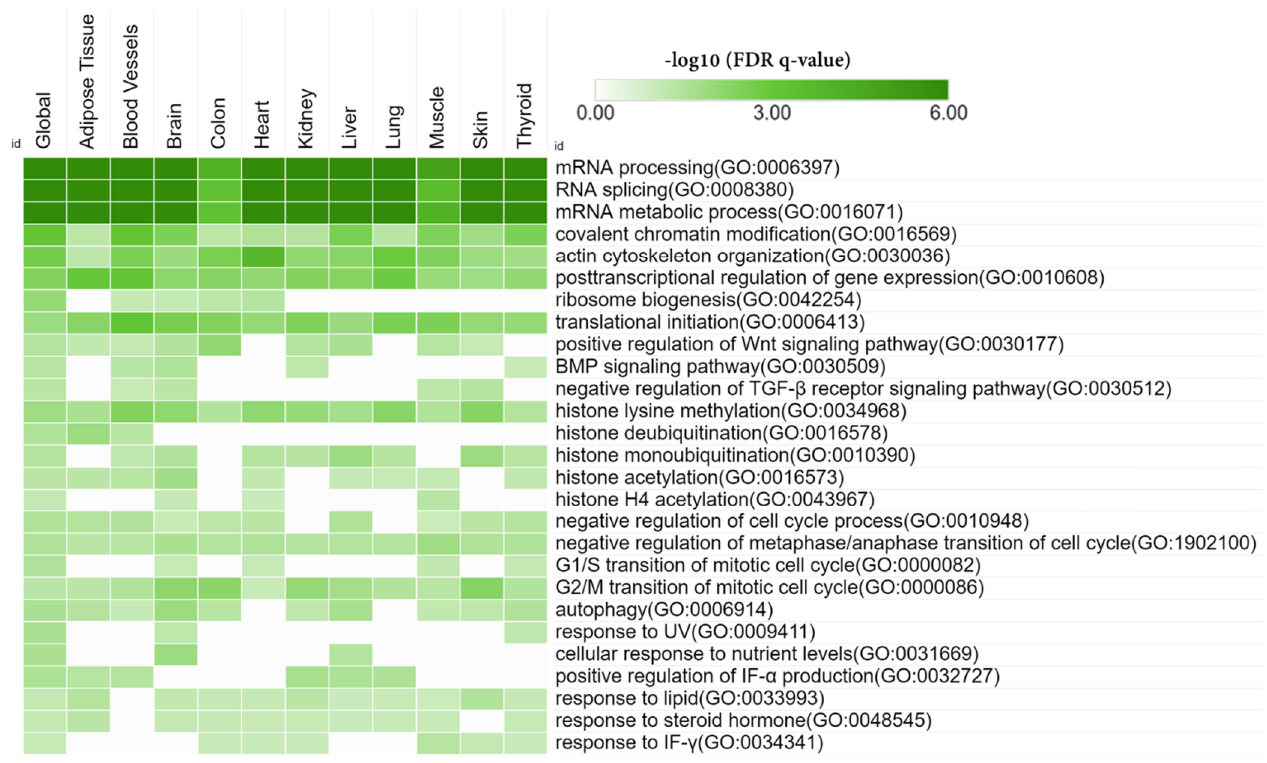
Figure 5. Tissue-specific network-based functional analysis of the downregulated DEGs. Downregulated DEGs significantly enriched RNA processing (mRNA processing